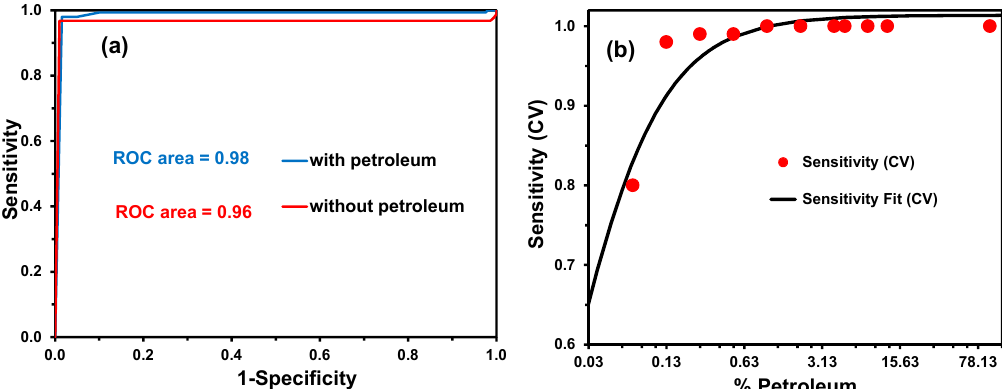
Table 4. SVM parameters for the fits and the 93% and 50% probabilities for petroleum sensing. Parameter